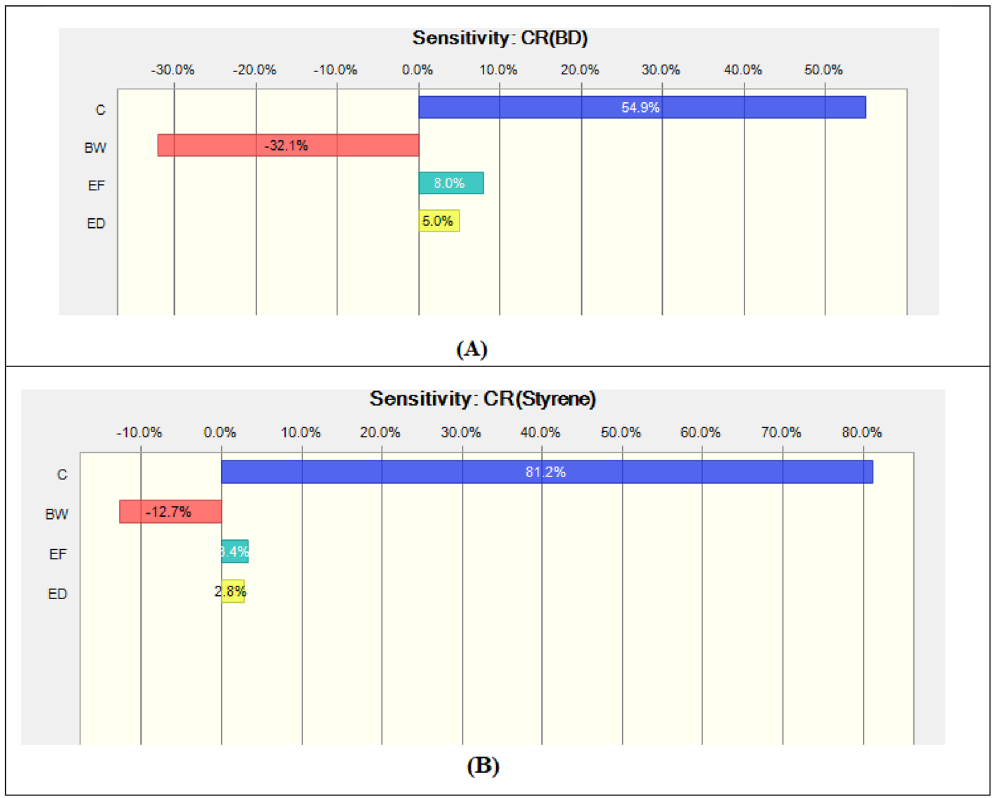
Figure 3. Sensitivity analysis of the cancer risk (CR) for ( A ) 1,3-butadiene, ( B )